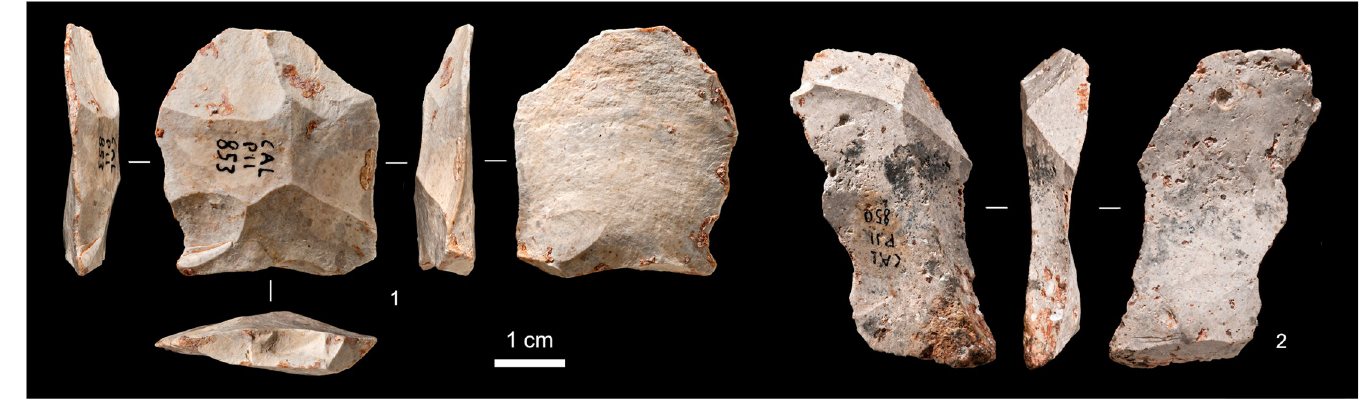
Fig 13. Chert flakes from layer O. 1. Levallois flake (P11-853). 2. Regular flake (P11-850).